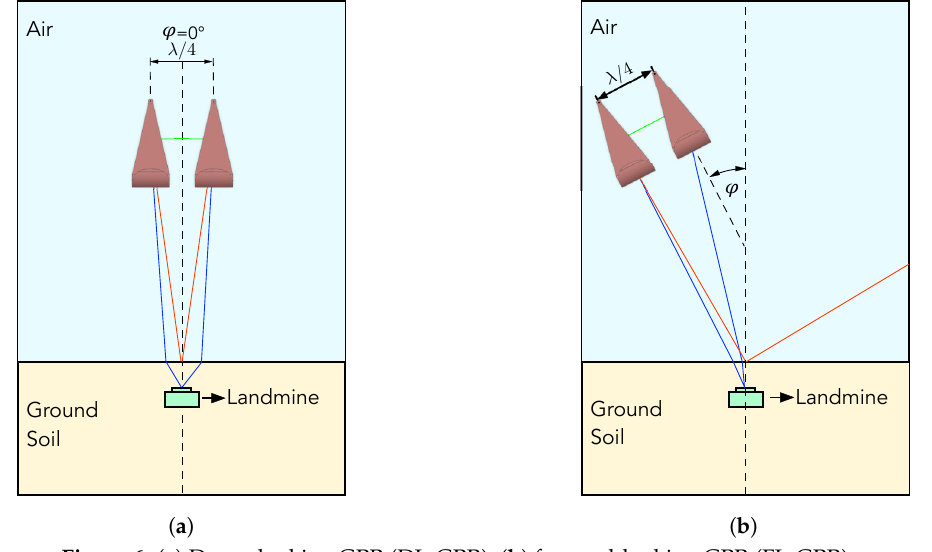
Figure 6. ( a ) Down-looking GPR (DL-GPR); ( b ) forward-looking GPR